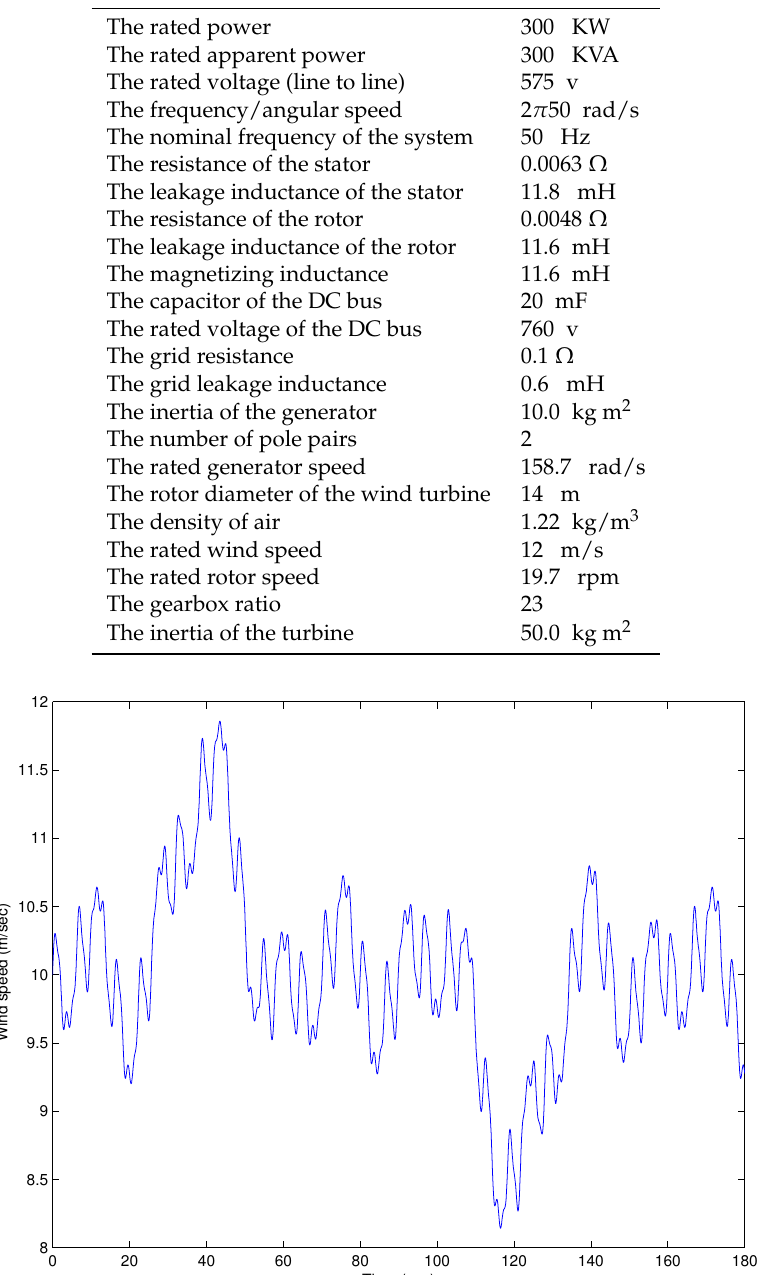
Table 1. The parameters of the SCIG and the wind turbine.